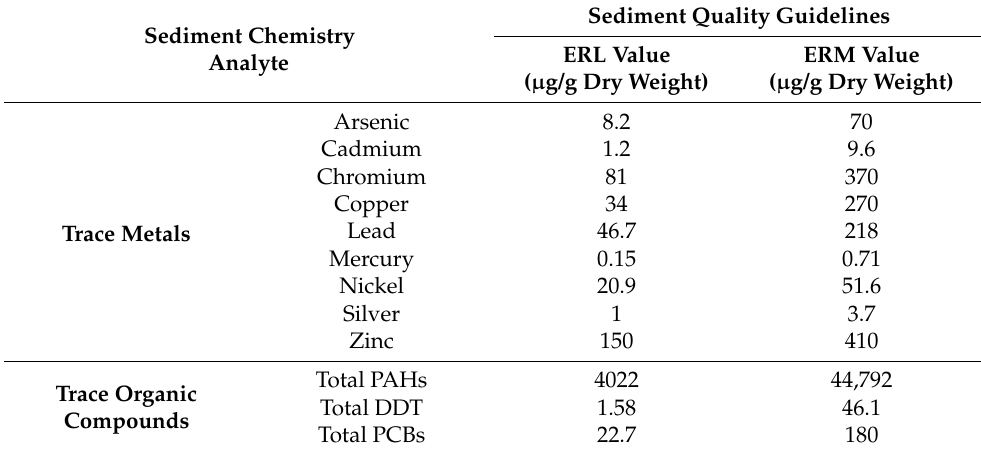
Table 2. Sediment quality guidelines (ERL and ERM). ERL = Effects Range-Low concentration and ERM = Effects Range-Median concentration. ERL and ERM values from Long et al.